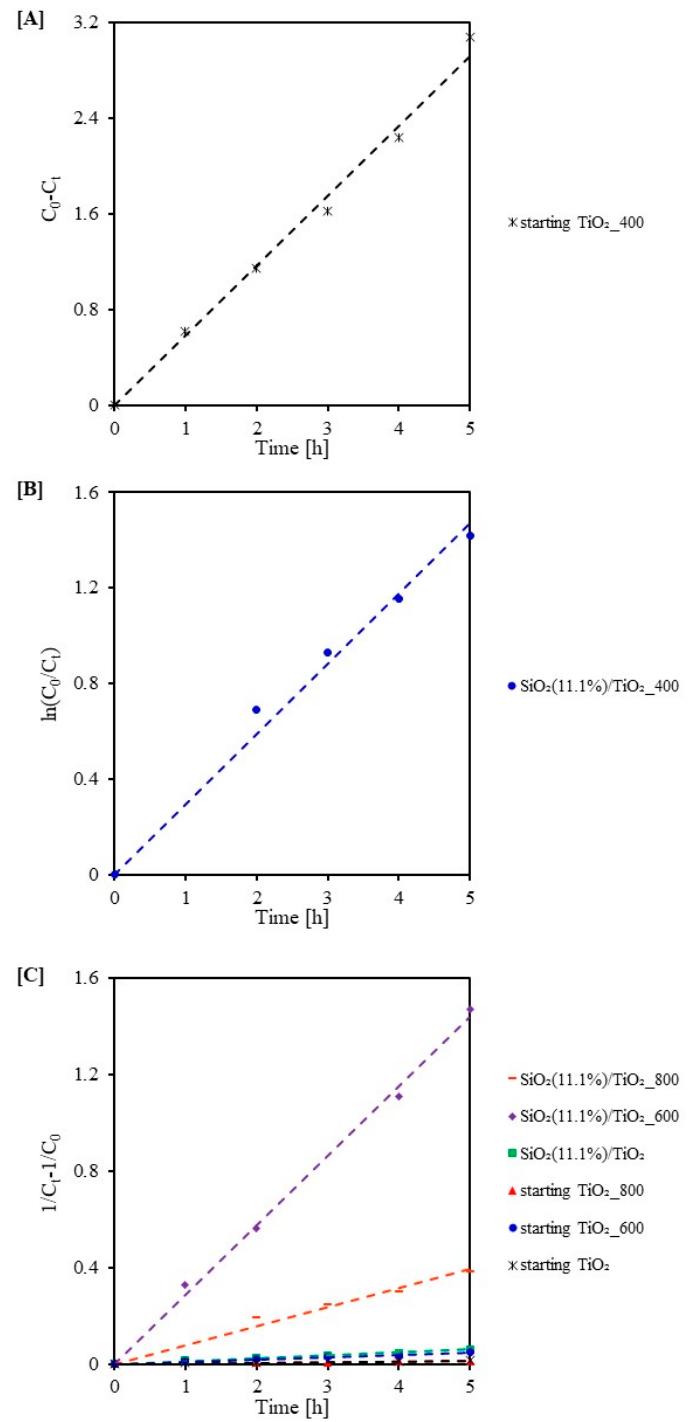
Figure 9. The zero-order plot ( A ), the pseudo-first-order plot ( B ), and the pseudo-second-order plot ( C ) of methylene blue decomposition during 5 h of irradiation under UV-VIS. Process conditions: C MB = 10 mg/L, V s = 0.5 L, C photocat. = 0.2 g/L, adsorption time—1 h.